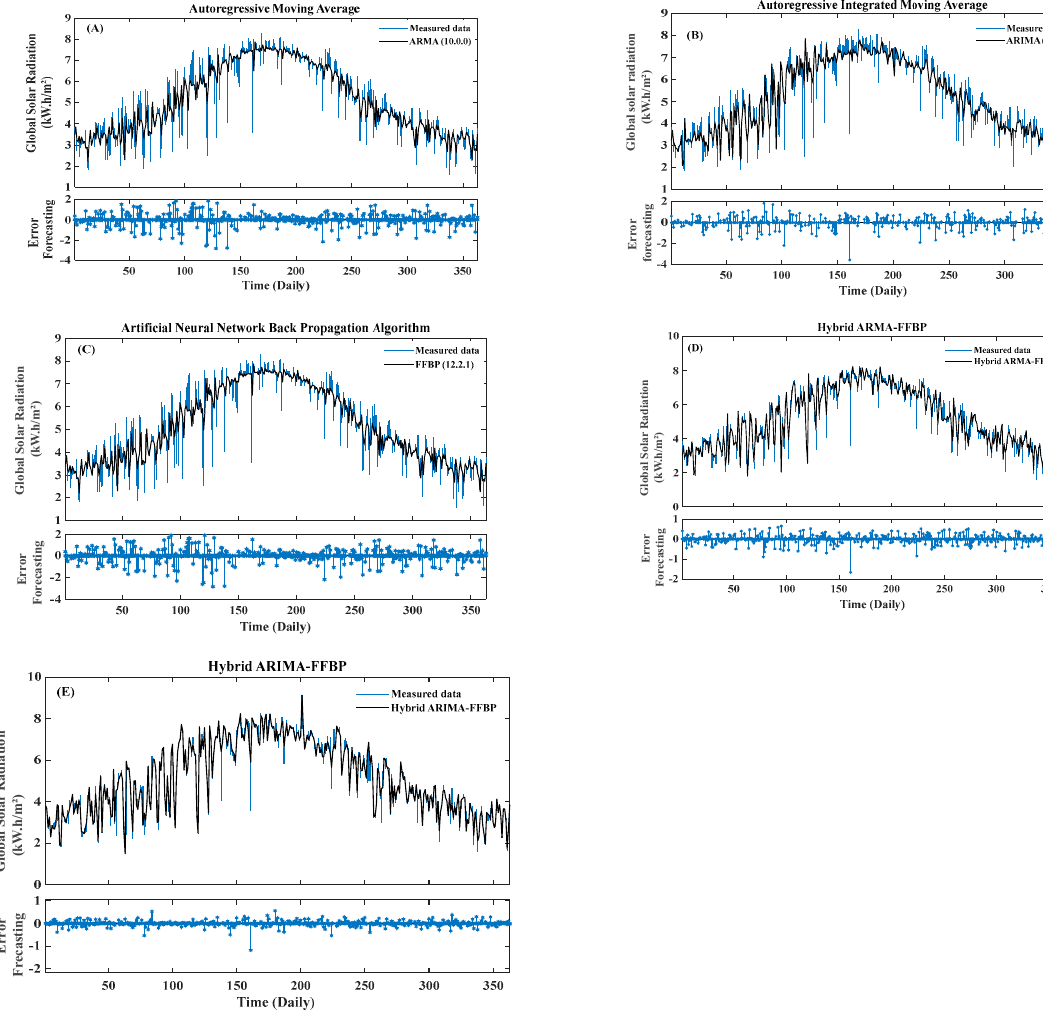
Figure 9. ( A – E ) Comparison between predicted and measured values of daily global solar radiation from ARMA, FFBP, ARIMA, and hybrid models. Table 6. Statistical results of the FFBP, ARMA, ARIMA, and hybrid network models.